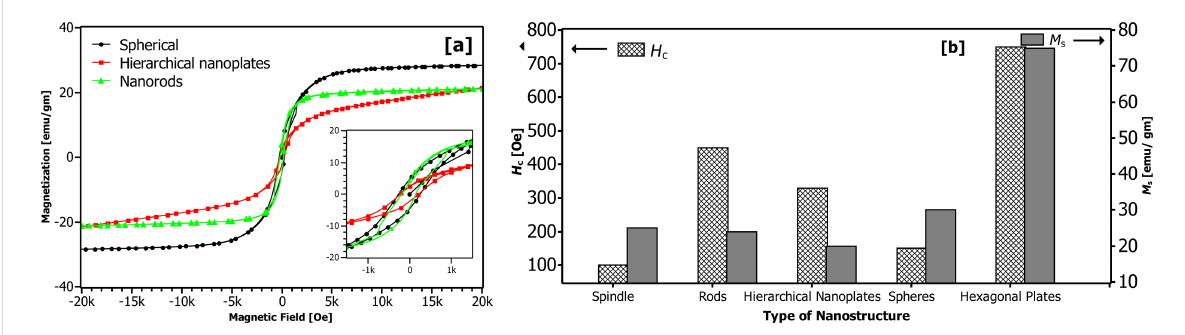
Figure 11: Magnetic properties of the synthesized nanostructures. (a) Magnetization versus magnetic field recorded at 300 K for Co-TMAH nanoplates, Co-TMAH rods synthesized at 50 °C, Co-TEAH hierarchical plates; (b) summary of saturation magnetization ( M s ) and coercivity ( H c ) of the